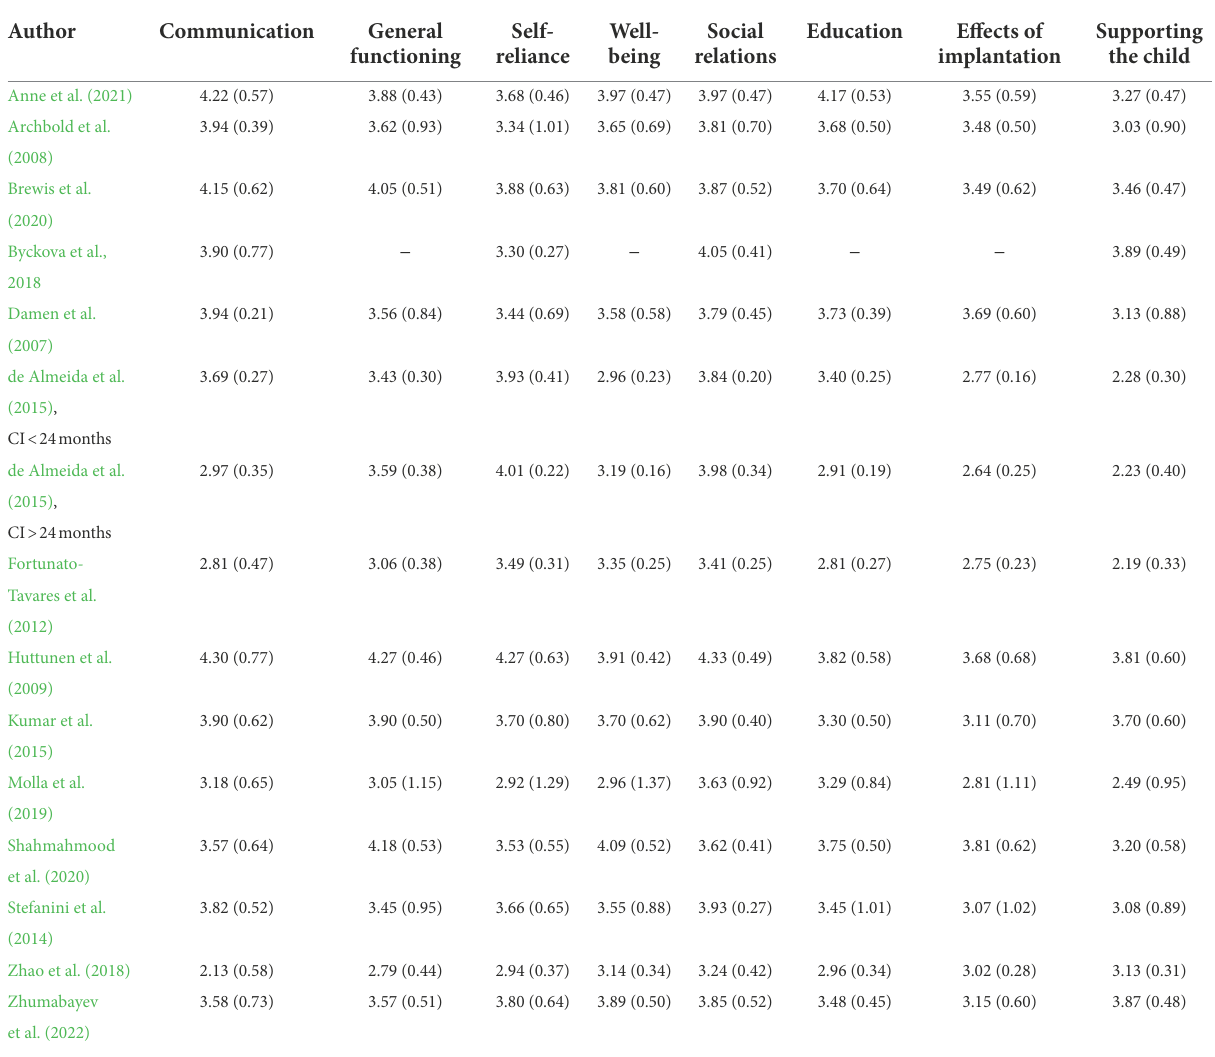
TABLE 2 Means and standard deviations by article and